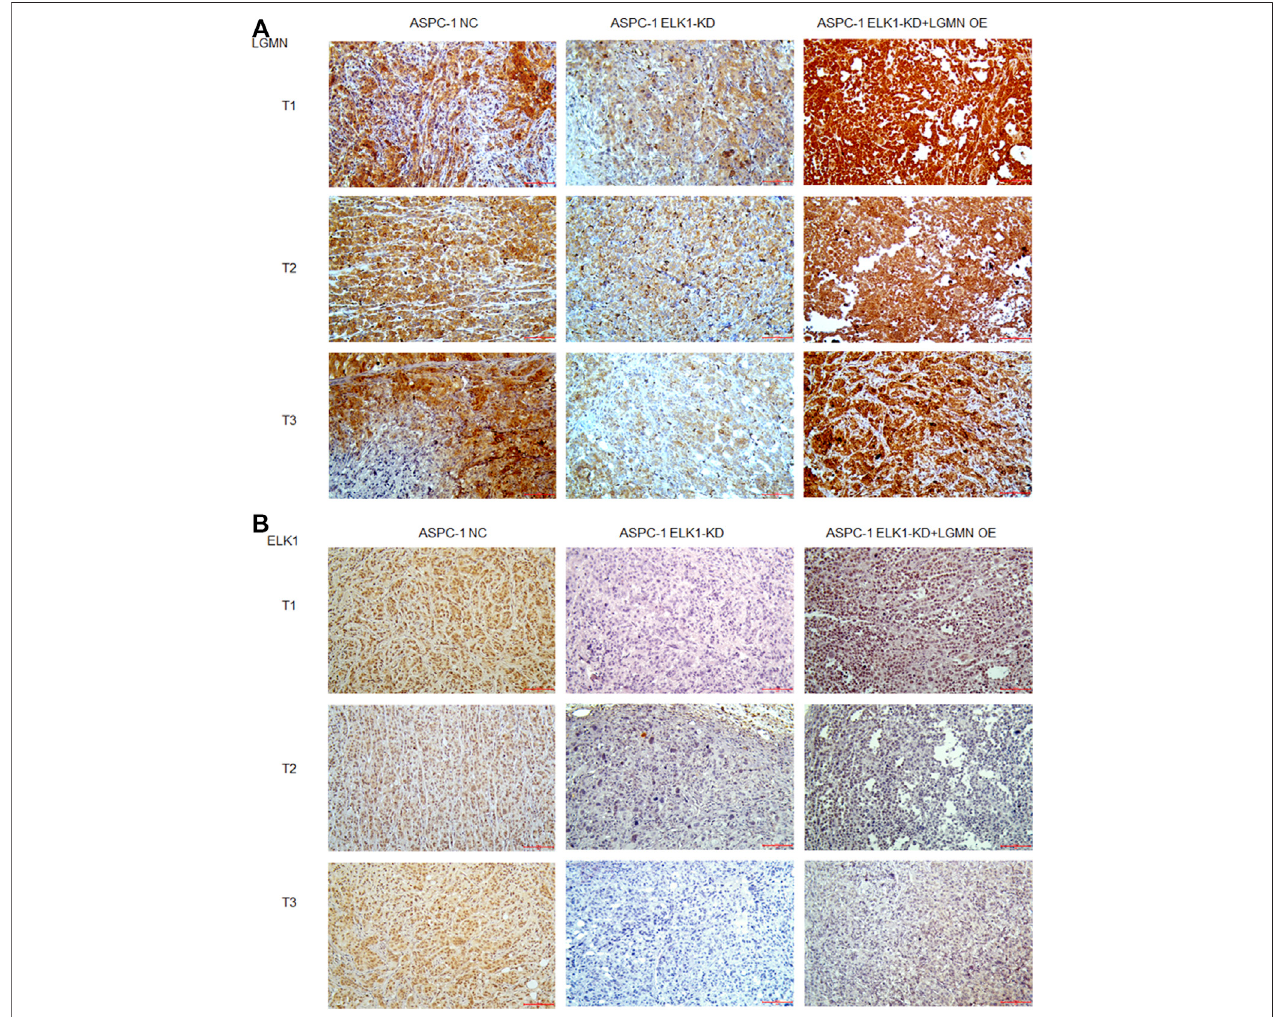
FIGURE7| ELK1 positivelycorrelatedwithLGMN expression invivo . (A , B) Immunohistochemical analysisofLGMN (A) and ELK1 (B) expression ofASPC-1cells. Figures shown that ELK1 and LGMN were expressed in ASPC-1 cells. ELK1 was not expressed in ELK1-KD group and ELK1-KD+LGMN-OE group. LGMN was rarely expressed in ELK1-KD group and rescued its expression in ELK1-KD+LGMN-OE group.